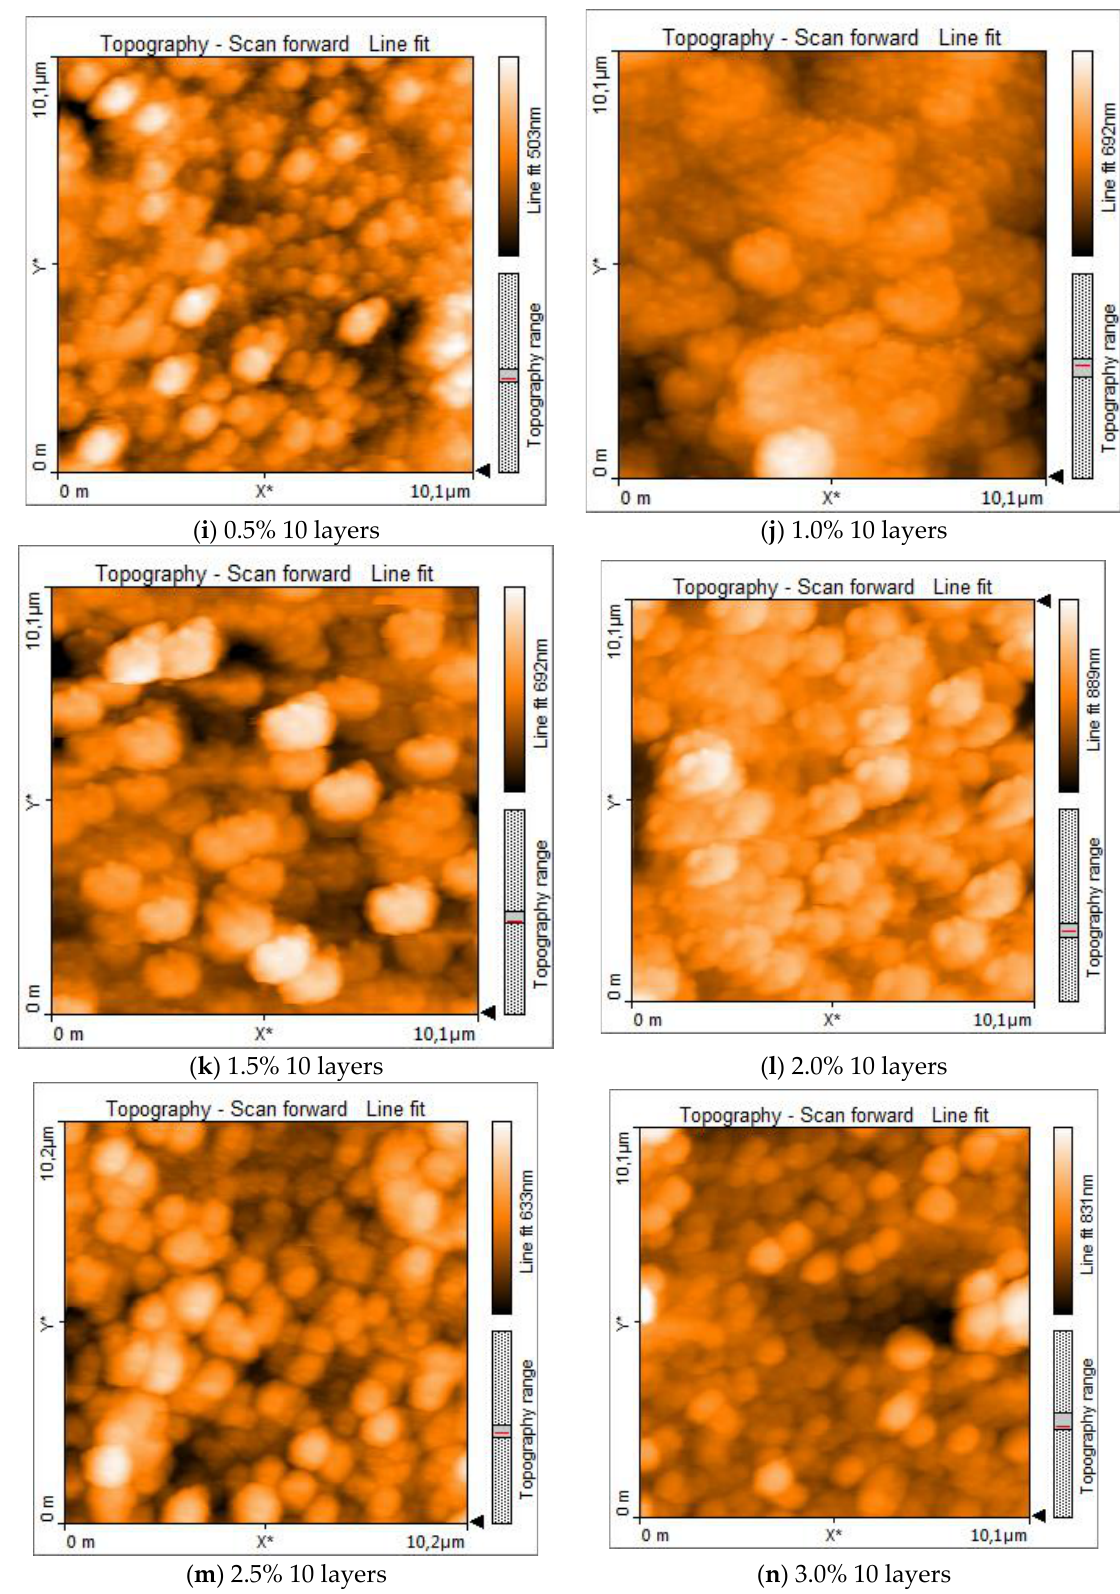
Figure 2. AFM images measured for 5- and 10-layered CuO thin films with various Sn doping concentrations. X* and y* refer to scale.